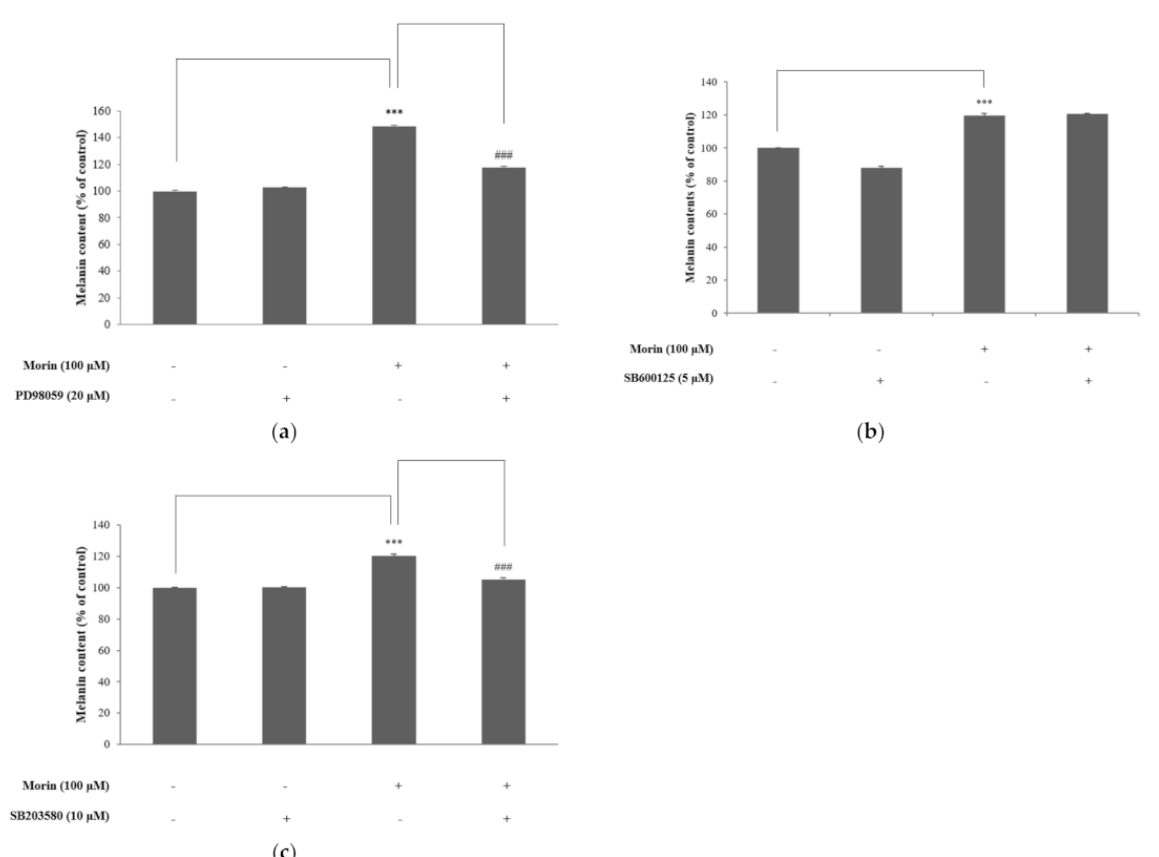
Figure 6. Effects of specific inhibitors of ( a ) ERK, ( b ) JNK, and ( c ) p38 on morin-induced melanin contents. Inhibitors (PD98059, SB203580) were pre-incubated with B16F10 mouse melanoma cells for 1 h before the addition of morin at 100 µ M. The data are presented as the mean ± SD of at least three independent experiments; *** p < 0.001 compared with the control. ### p < 0.001 compared with morin